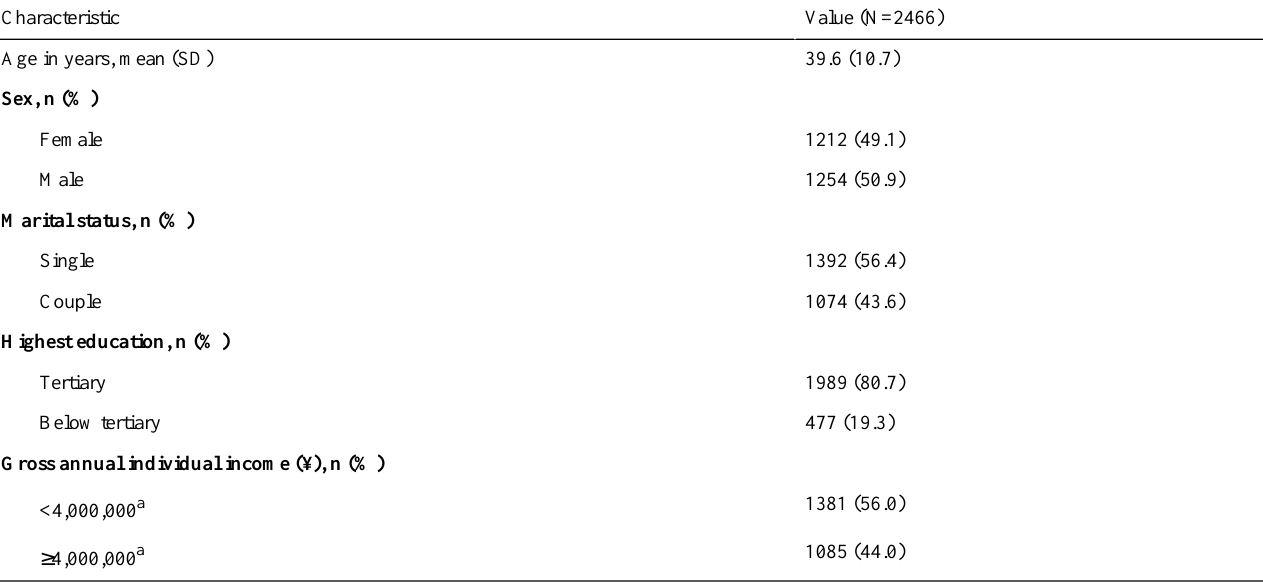
Table 1. Baseline characteristics of study participants in Japan, February